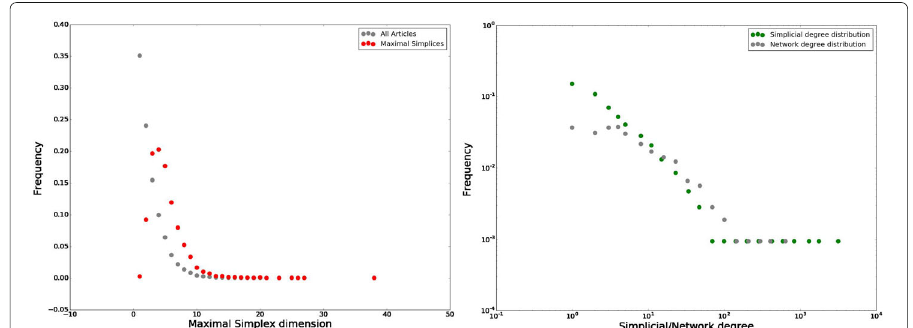
Fig. 1 Dimension of maximal simplices and simplicial degree. On the lefthand side the distribution of number of concepts per article. Here we compare the distribution of the entire dataset (grey) with that of the papers included in the simplicial complex, which shows that most of the articles with few concepts in are not included as they are a subset of other articles. On the righthand side the simplicial and network degree distribution are